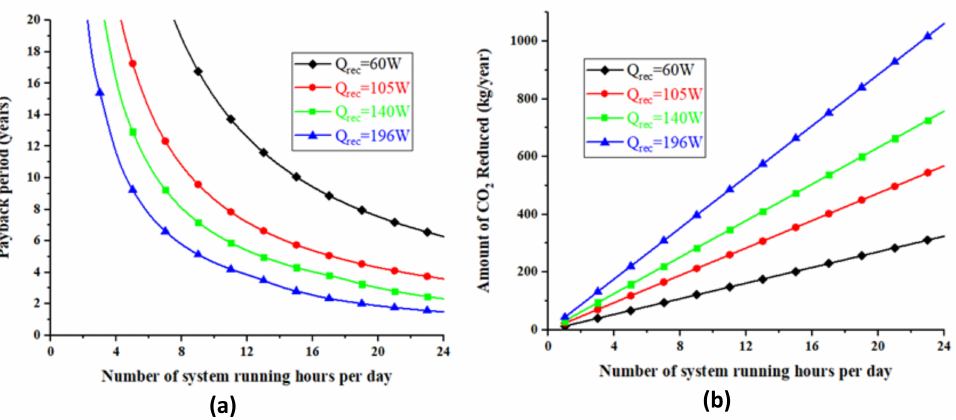
Figure 6. ( a ) Heat recovery system’s payback period in years, and ( b ) amount of CO 2 gas re- duced